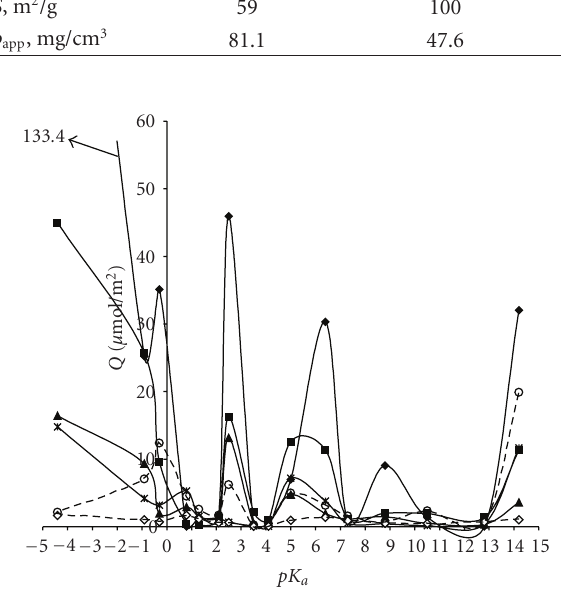
Figure 1: Distribution of adsorption centers as a function of their p K a values on the surface of electron beam evaporated silica samples with the specific surface areas S = 59 (